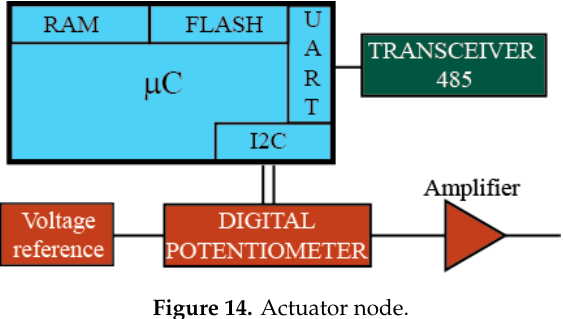
Figure 14. Actuator node.